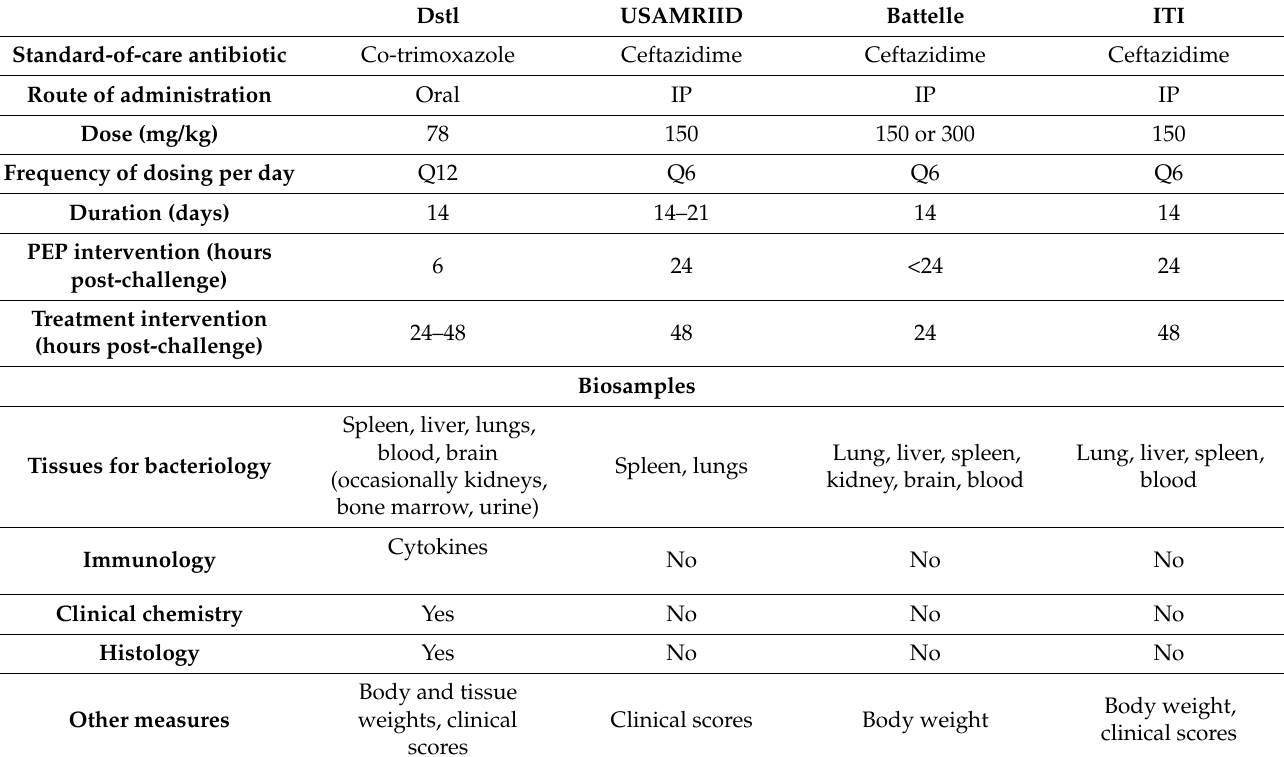
Table 4. Antibiotic and biosample